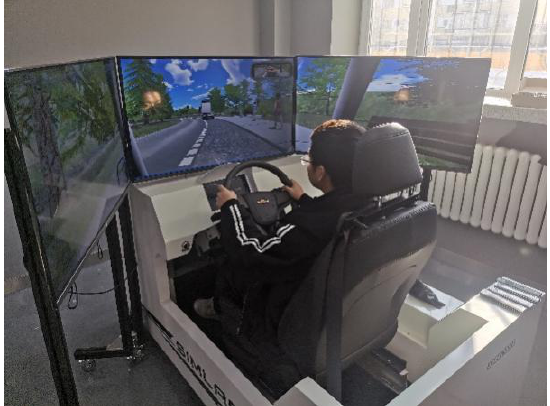
Figure 12. Driver-in-the-loop experiment to collect drivers’ reactions to different working